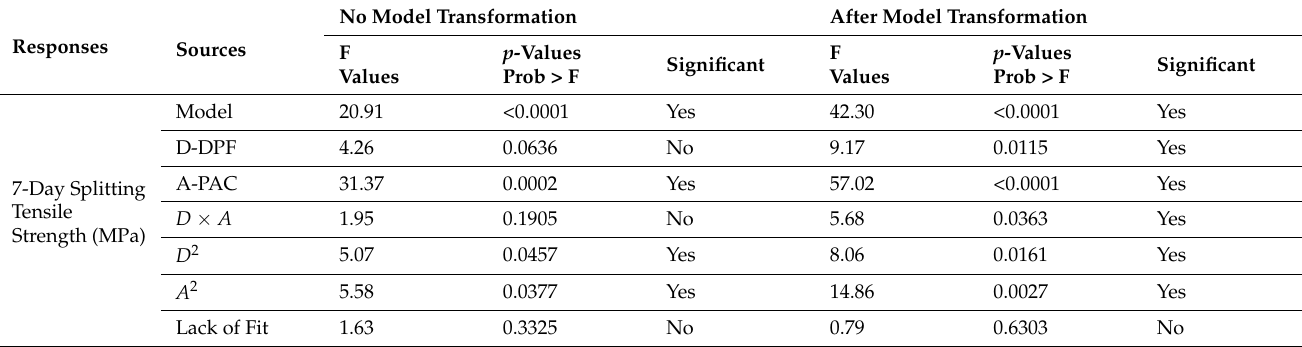
Table 8. Summary of ANOVA for Splitting Tensile